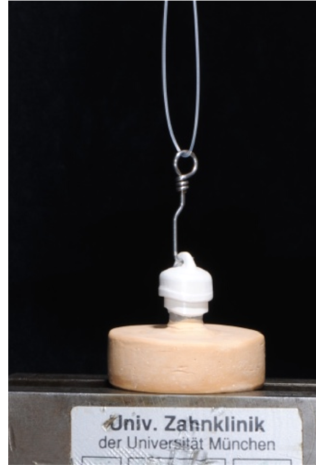
Figure 6. Experimental setup for the pull ‐ off test: a hook pulls a zirconia secondary crown off a PEEK primary crown.